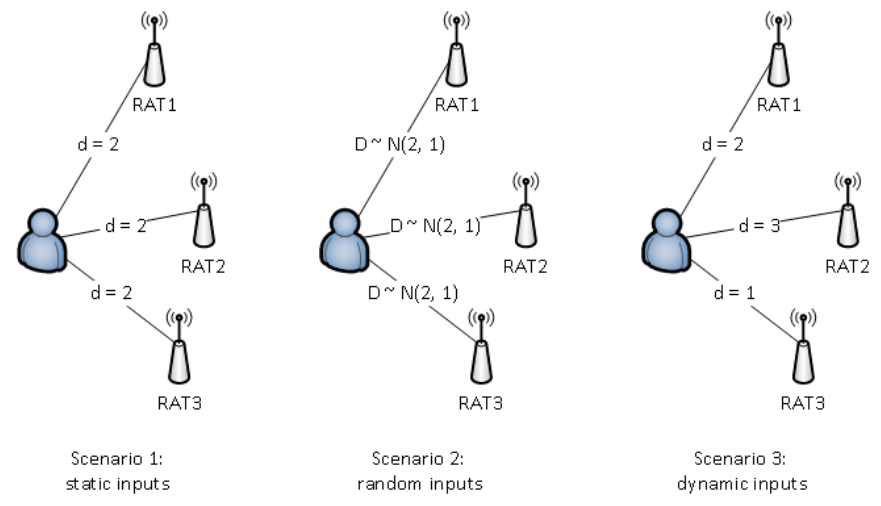
Fig. 1. Different scenarios according to the nature of the